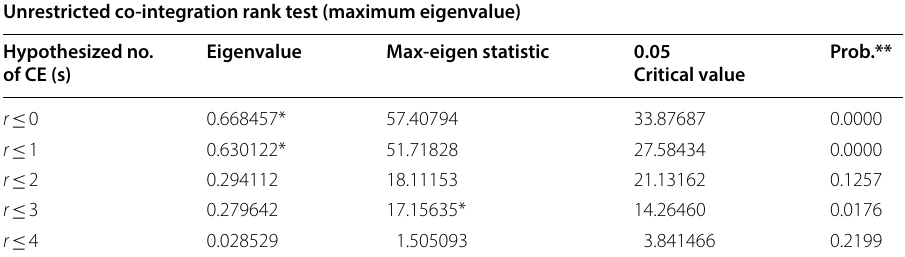
Table 10 Unrestricted co-integration rank test result (maximum